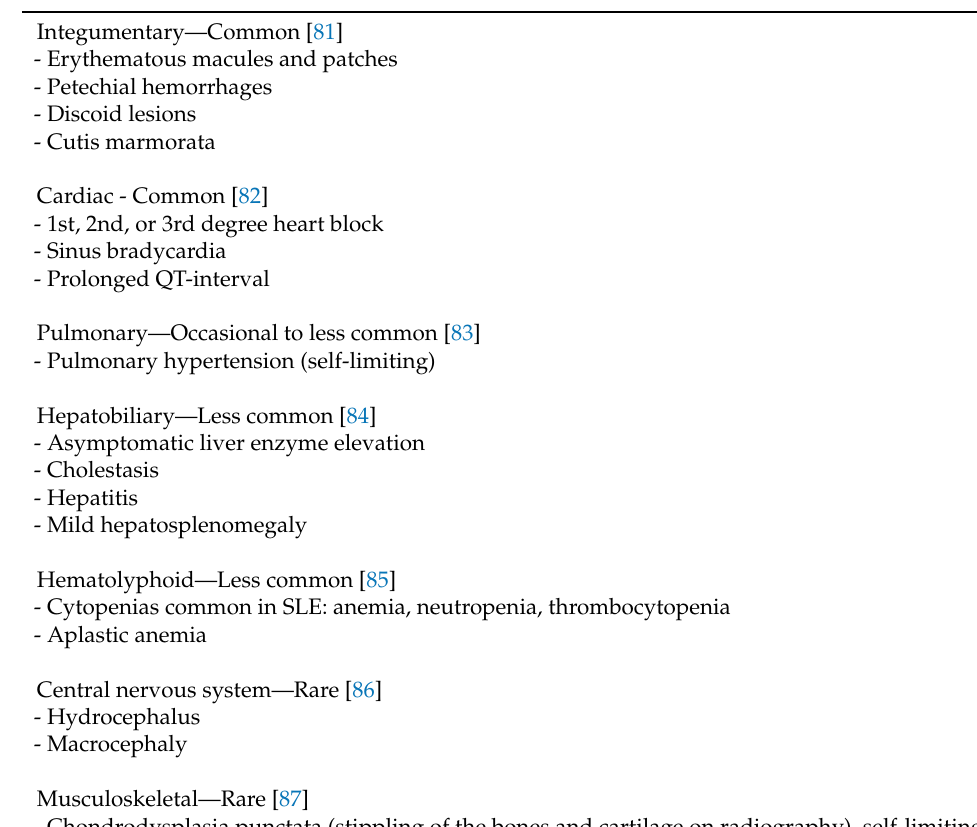
Table 2. Clinical manifestation of neonatal lupus by the organ